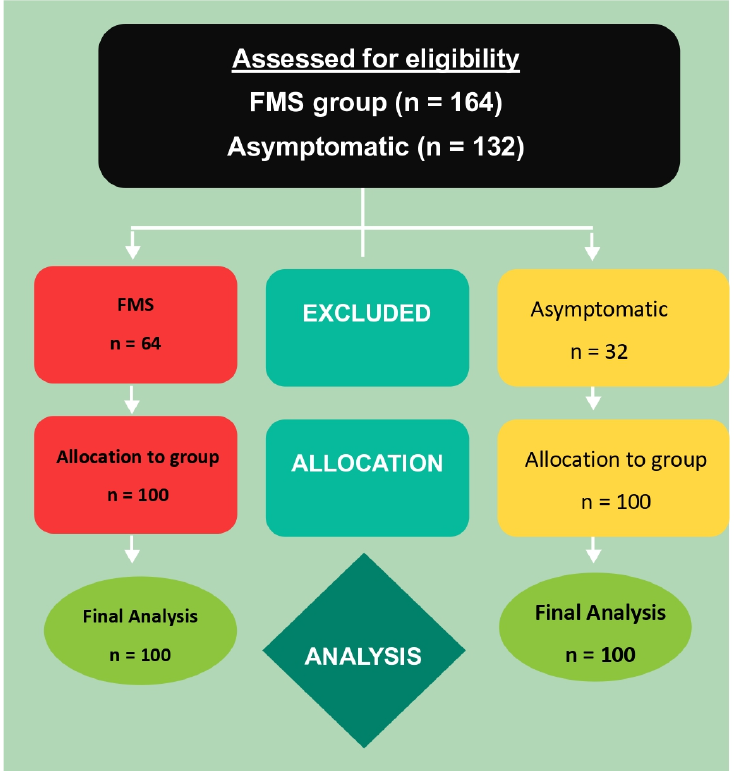
Figure 4. Consort flow of the cross-sectional study.